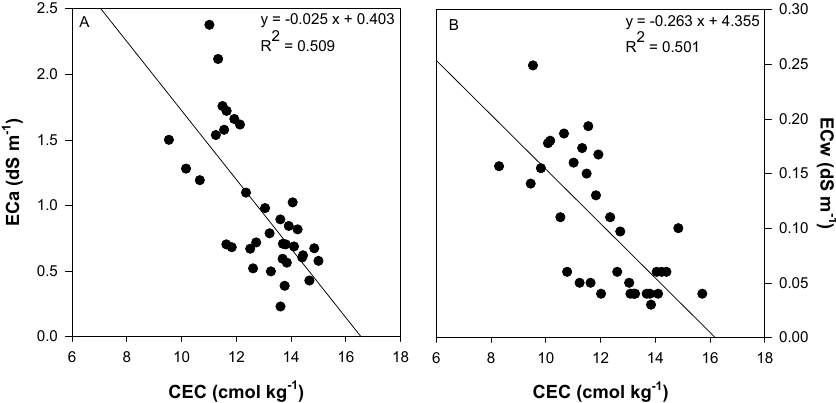
Figure 10. Relationship between cation exchange capacity and electrical conductivity of soil solution, EC w ( A ) and bulk electrical conductivity, EC a ( B ) at 0–10 cm soil depths in podzolic soils under various nutrient management practices.